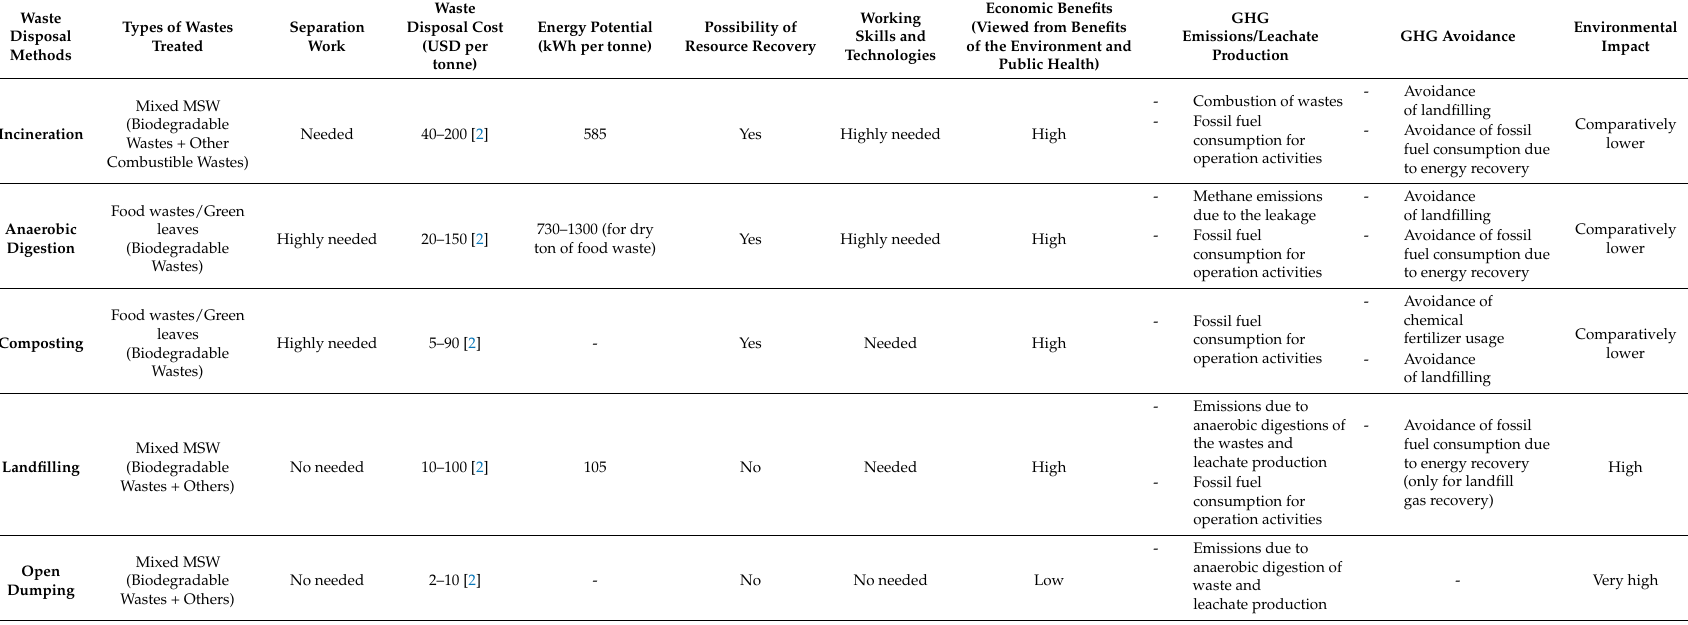
Table 4. Comparison of the major waste disposal methods for biodegradable wastes